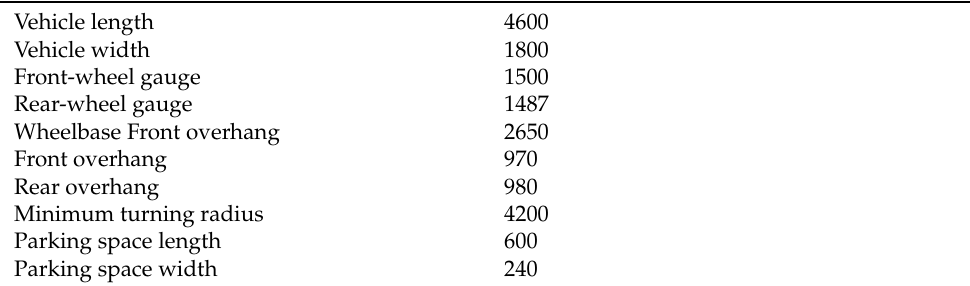
Table 2. Simulation parameters [mm].